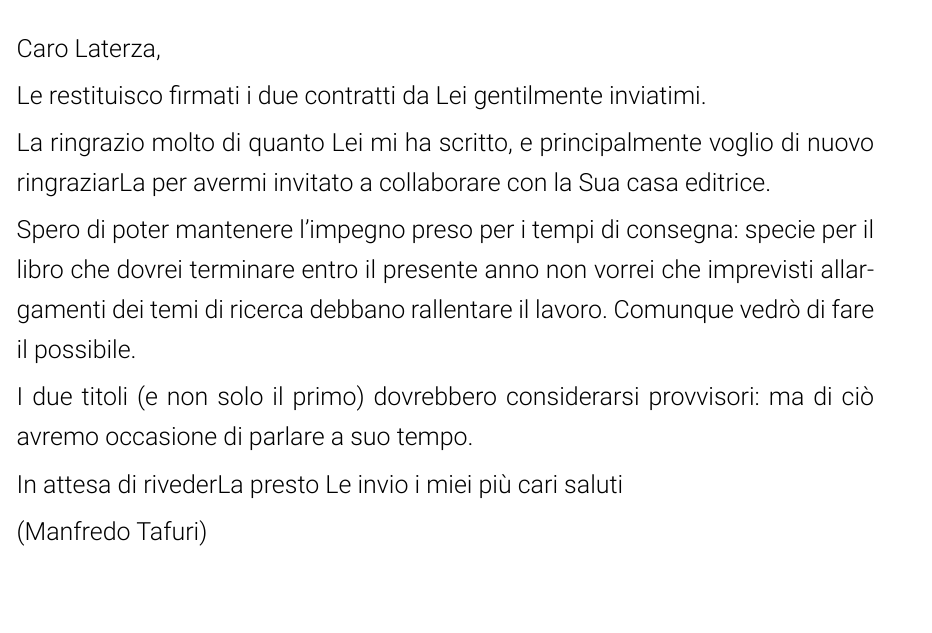
Manfredo Tafuri, typewritten and signed letter to Vito Laterza. Rome, 14 April 1967 (Source and credits: Archivio Autori Editori Laterza – per gentile concessione / Archivio Autori Editori Laterza – with kind